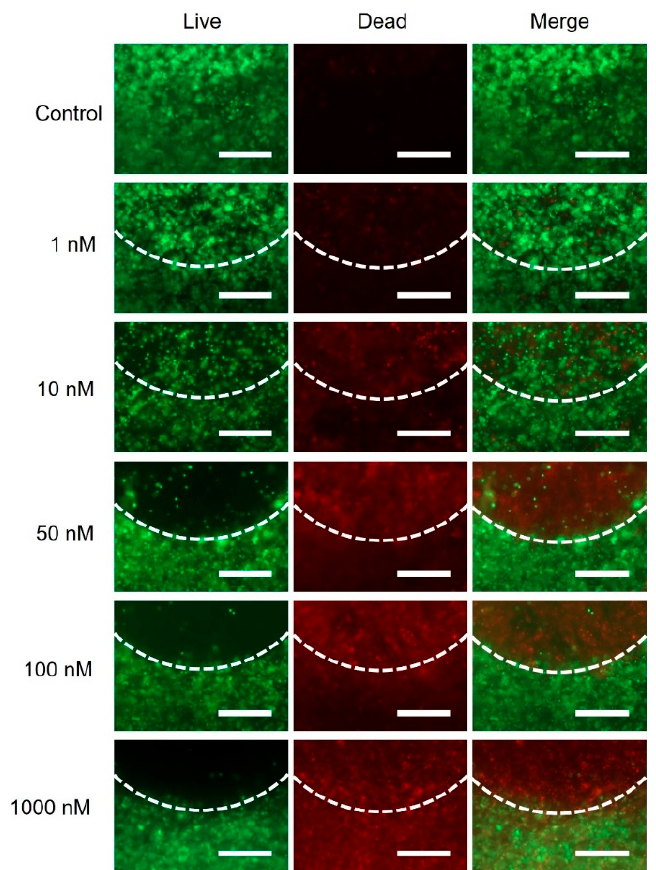
Figure 8. Cytotoxicity of cancer (IMR-32) and non-cancerous environment (primary kidney fibroblasts) of the bioprinted models after treatment with panobinostat. Cytotoxicity assays of cancer models were carried out after treatment with panobinostat for 72 h. Living cells were labeled in green, and dead cells were in red. The white dotted lines indicate the boundary between cancer part (above the line) and non-cancerous environment (below the line). All images were taken at the same magnification; scale bar, 500 µm.